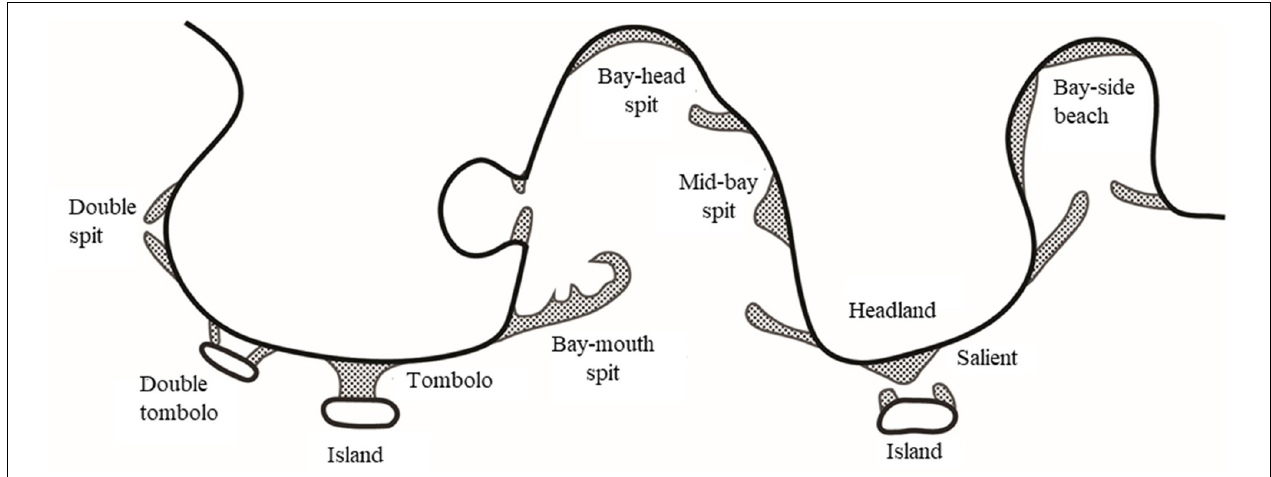
FIGURE 9 | Overview of sandy coastal shapes, from van Rijn